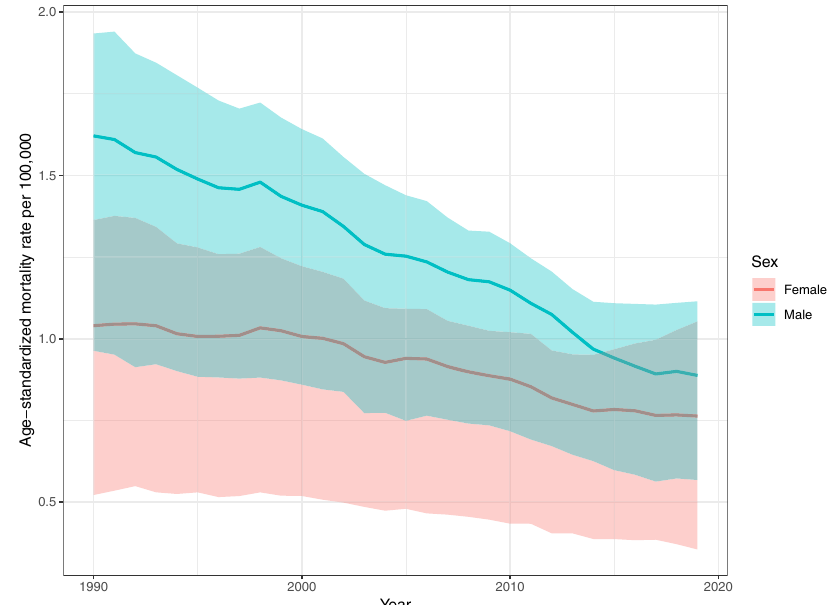
Fig. 1 | Global age-standardized mortality rate of snakebite envenoming in males and females from 1990 to 2019. The upper and lower estimates of the 95% uncertainty interval are represented by the error bands around the mean estimate. Source data are provided as a Source Data fi